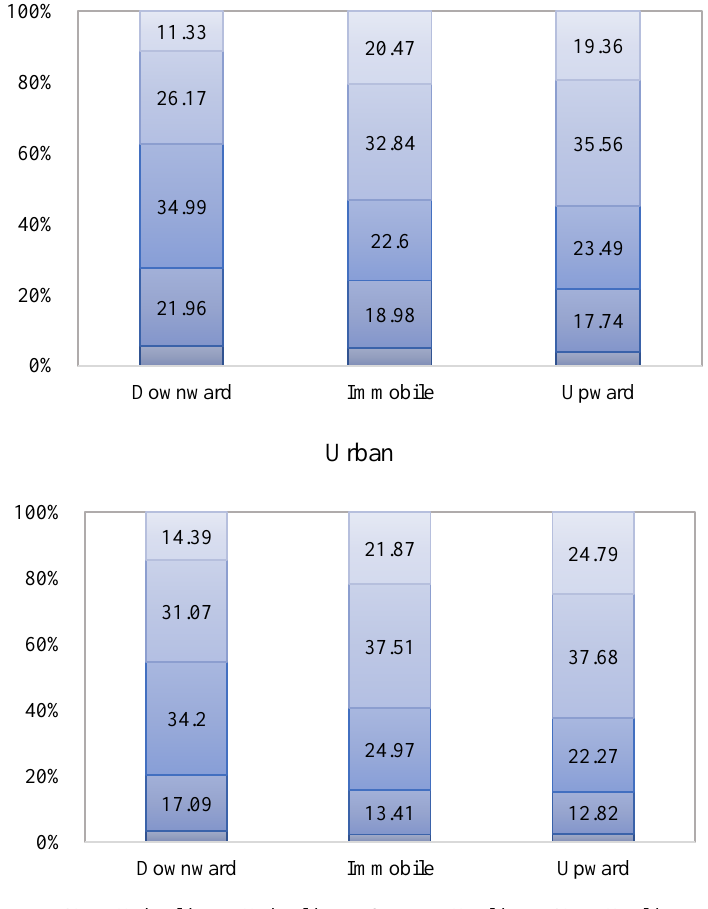
Figure 2. Distribution of Self-Rated Health by Self-Perceived Class Mobility.